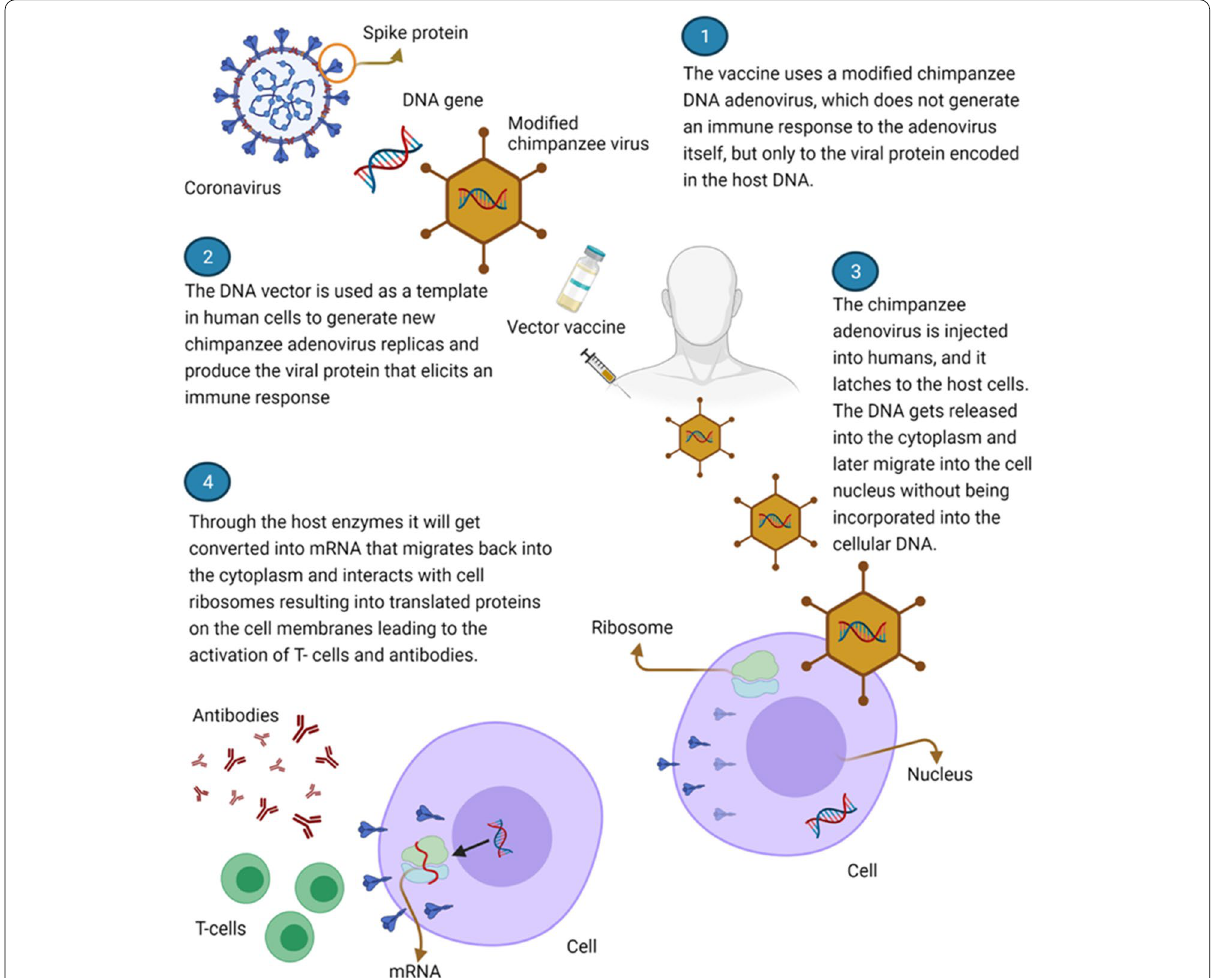
Fig. 4 Represents a summary of the mechanism of action of AstraZeneca vaccines